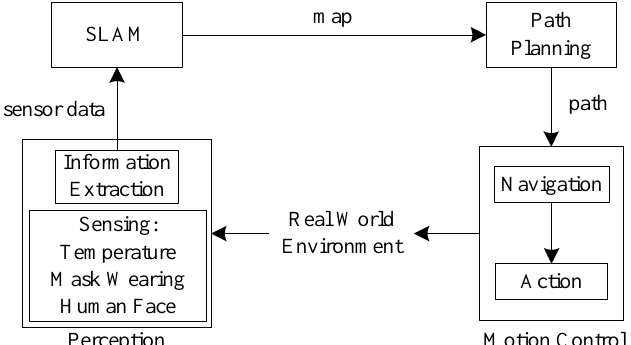
Figure 5. System architecture.